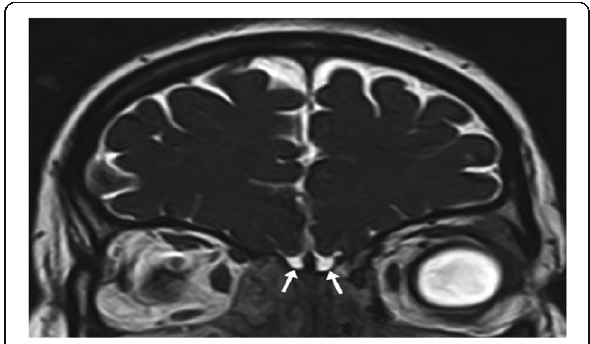
Fig. 1 Coronal T2-WI showing segmentation of the olfactory bulb for volumetric